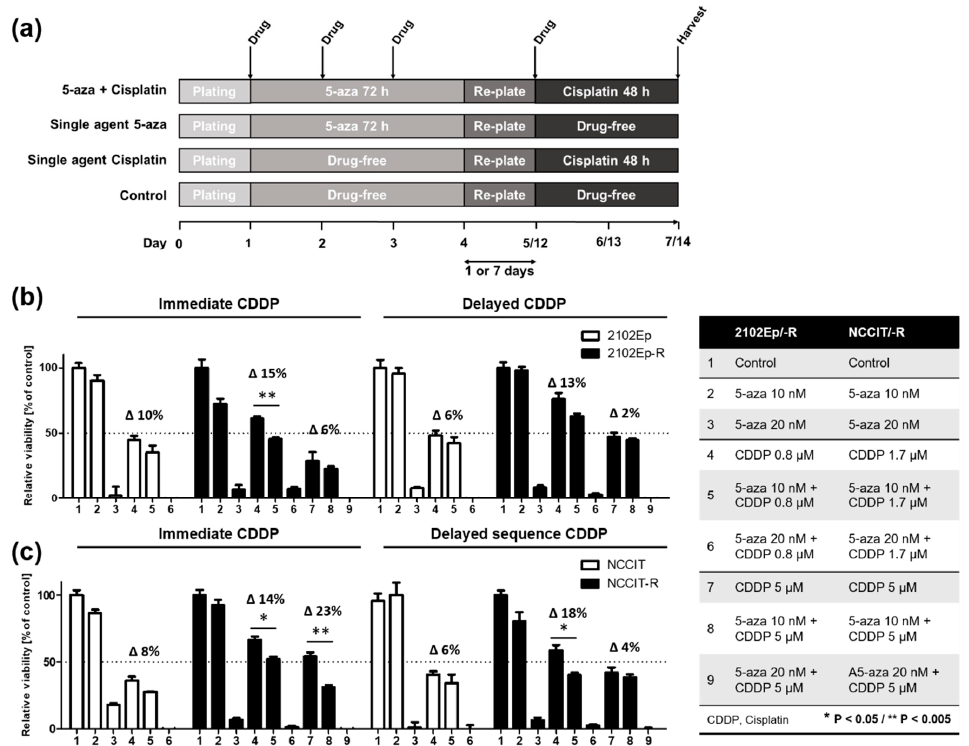
Figure 4. Cell viability assay ( a ) showing enhanced toxicity of 72 h exposure to 20nM 5-aza (~IC 50 ) plus 72 h off treatment among all cell lines, 2102Ep/-R and NCCIT/-R ( b , c ). A significant sensitization towards a regular dose of cisplatin by adding a low dose of 5-aza (10 nM) was achieved in both resistant sublines by either immediate or delayed sequential treatment decreasing viability by 13–18%. This effect was less clear and not significant in the sensitive cell lines. Shown are mean and SD of a single triplicate experiment. Each experiment was conducted at least three times with similar results. CDDP, Cisplatin; ∆ , numeric difference between relative viabilities